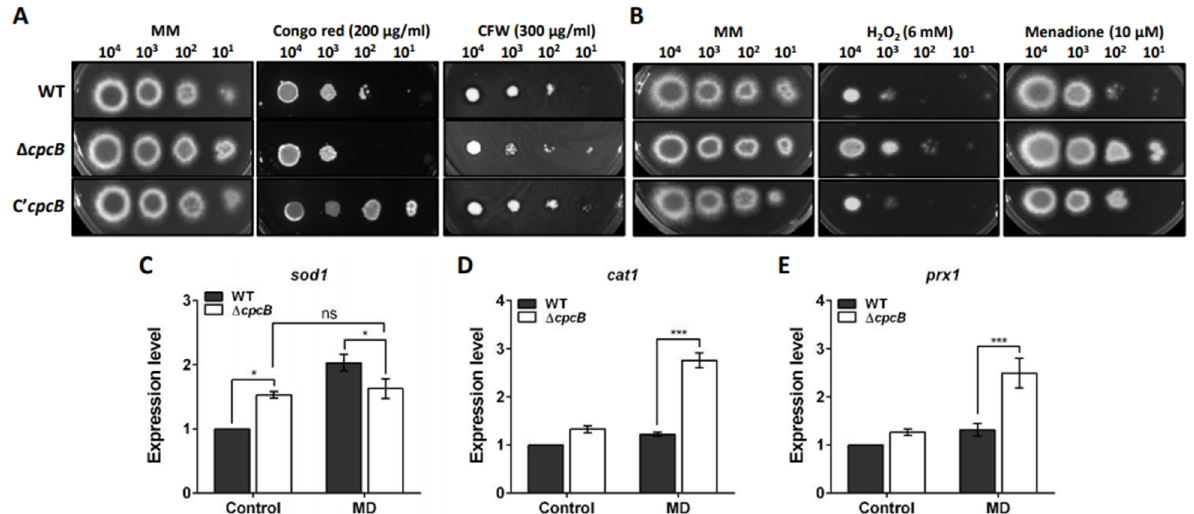
Figure 6. Cell wall and oxidative stress response mediated by Af CpcB. Conidia with 10-fold serial dilutions were spotted onto media and cultured at 37 °C for 2 days. ( A ) Sensitivity of the strains to cell wall stresses (200 μ g/mL of Congo red and 300 μ g/mL of CFW). CFW, Calcofluor-white. ( B ) Sensitivity of the strains to oxidative stresses (6 mM H 2 O 2 and 10 μ M MD). MD, menadione. Expression patterns of genes associated with oxidative stress response, ( C ) sod1 , ( D ) cat1 , and ( E ) prx1 under MD treatment conditions ( n = 4–8). Mycelia were cultured in liquid broth, transferred onto GMM (Control) and GMM containing 10 μ M MD, and incubated for 6 hr. The RT-qPCR expression ratios were normalized using 18S rRNA gene. Statistical analysis was performed using Student’s t -test. * p < 0.05, *** p < 0.001. “ns” indicates not significantly different.